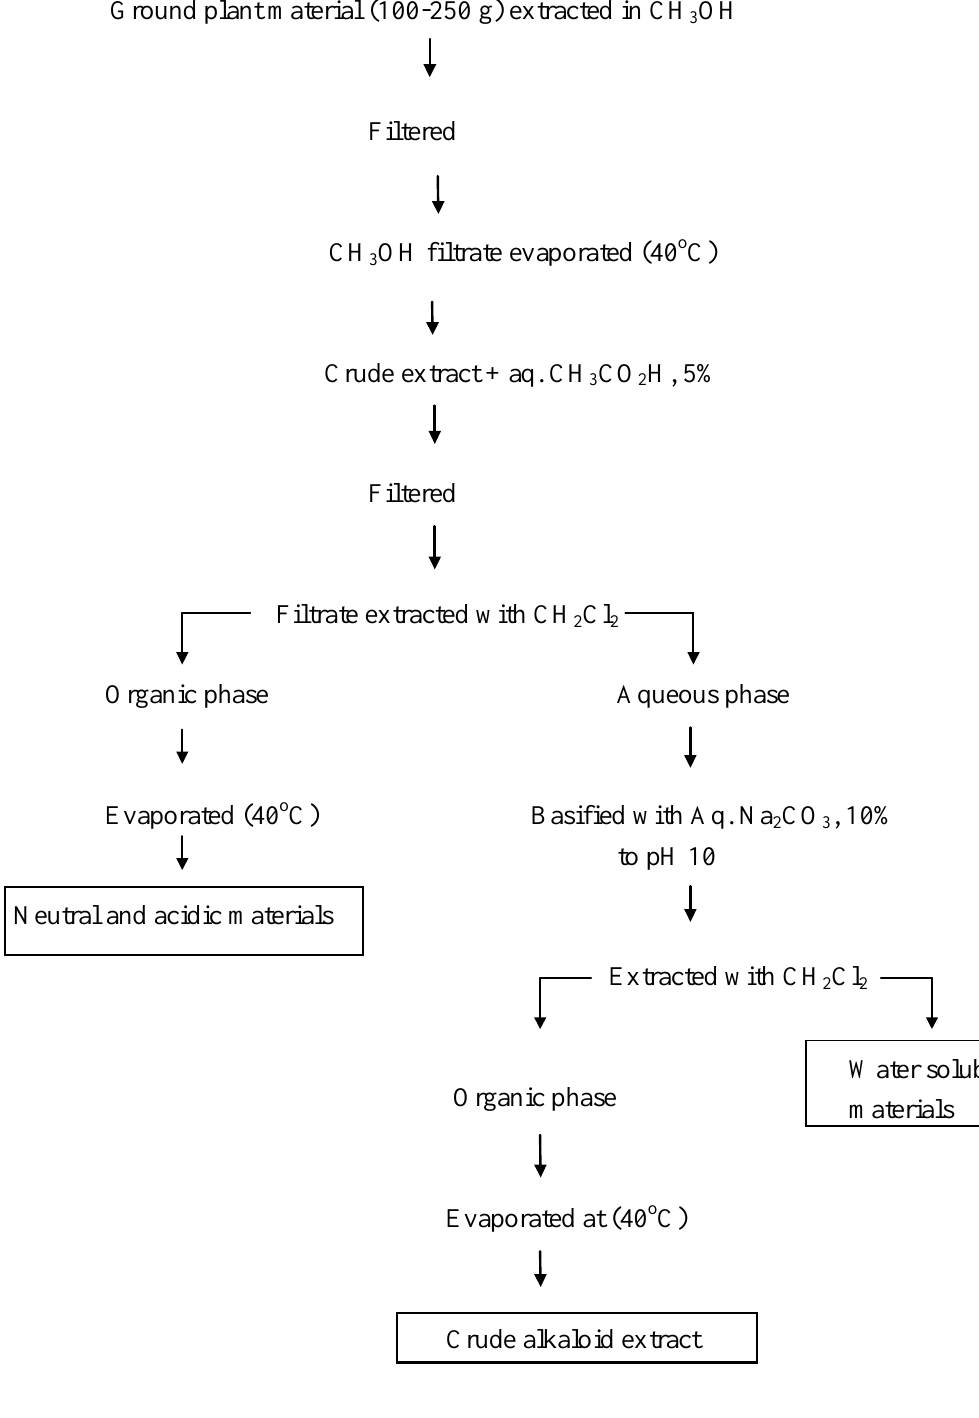
Figure 1. Outline of the extraction procedure for alkaloids carried out for selected medicinal plants of